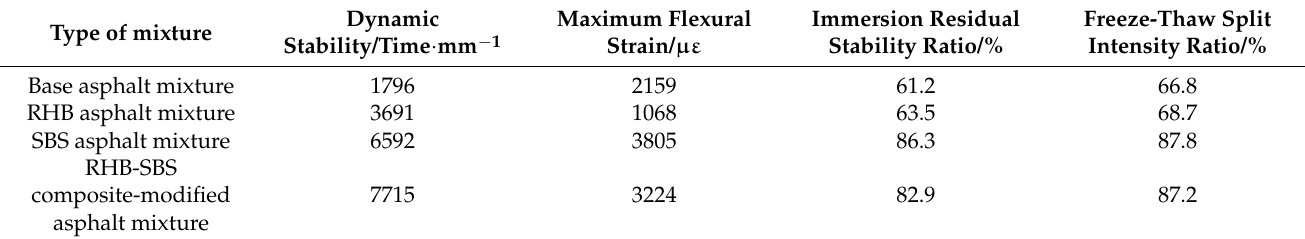
Table 5. The road performance of different asphalt